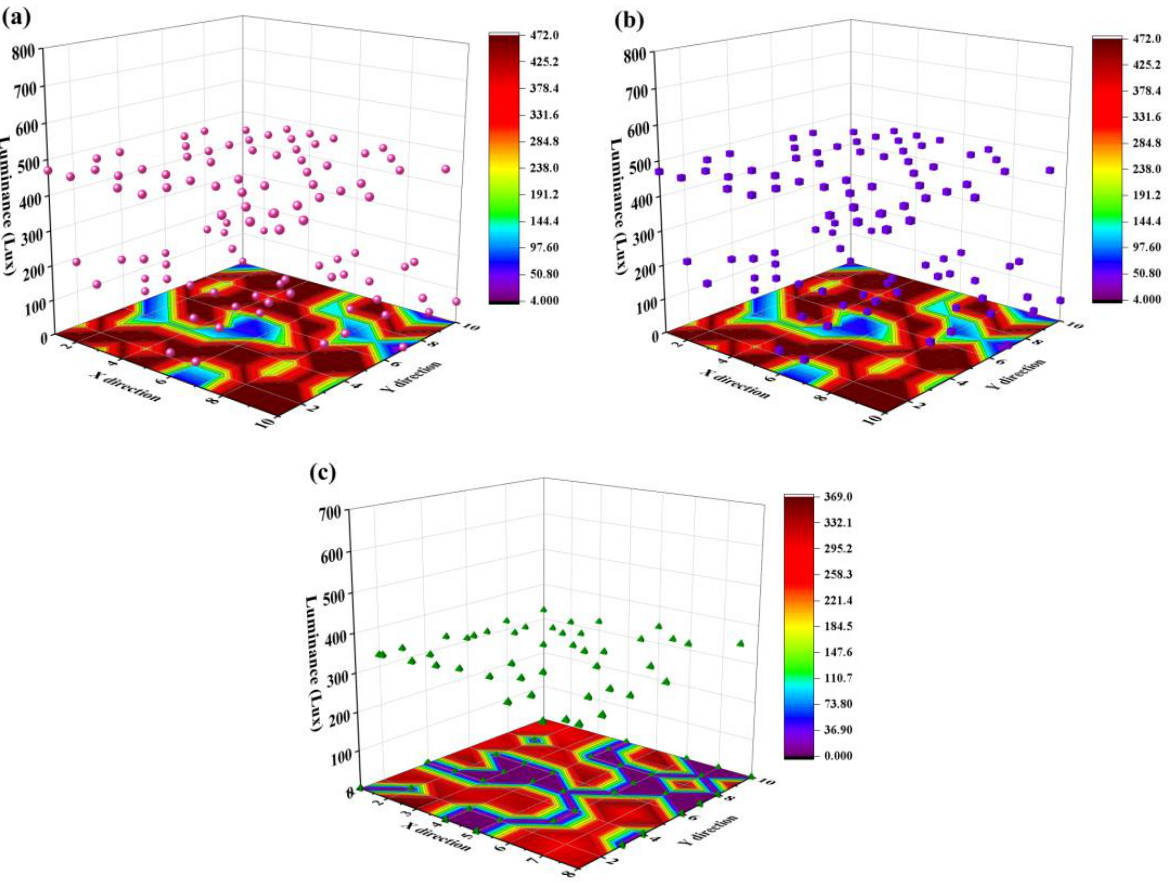
Figure 7. ( a ) Target spatial illuminance distribution ( E t ) of the WLED matrix with inhomogeneous distribution of users. ( b ) Optimized spatial illuminance distribution ( E o ) of table tops under the WLED matrix with inhomogeneous distribution of users. ( c ) Spatial illuminance distribution emit- ted by the WLED matrix ( E r ) with an inhomogeneous distribution of users. Calculation results were